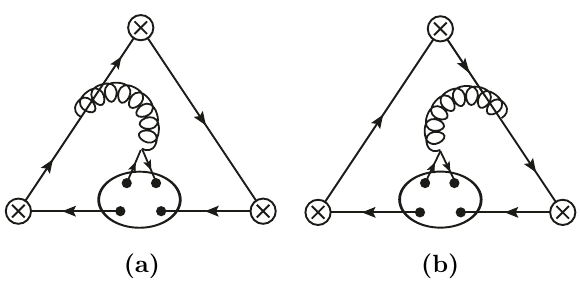
Figure 11. Feynman diagrams of the contributions of the four-quark condensate to the three-point Green functions due to the e(cid:11)ective propagation of the nonlocal quark condensate (8.5).